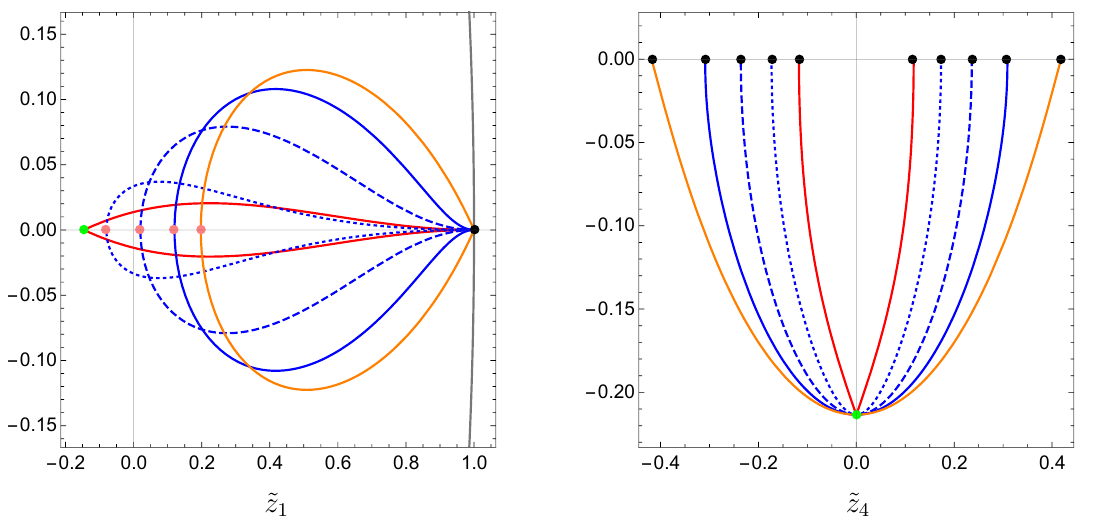
Figure 2 . Samples of regular flows within the SU(3) -invariant sector using the boundary condi- tions (3.25) for the complex scalar fields ˜ z (left) and ˜ z (right). The N = 1 & SU(3) AdS vacuum 1 4 4 and the D3-brane asymptotics are denoted by green and black dots, respectively. The grey line in the left plot corresponds to the boundary values | ˜ z = 1 . The red flow corresponds to the choice 1 | (cid:15) ≈ 0 whereas the orange one corresponds to (cid:15) ≈ (cid:15) crit . Black dots in the right plot are compatible with SO(6) invariance, i.e. ˜ z is real-valued, and correspond to the values ± Φ of the type IIB 4 0 dilaton in the D3-brane asymptotics at r → ±∞